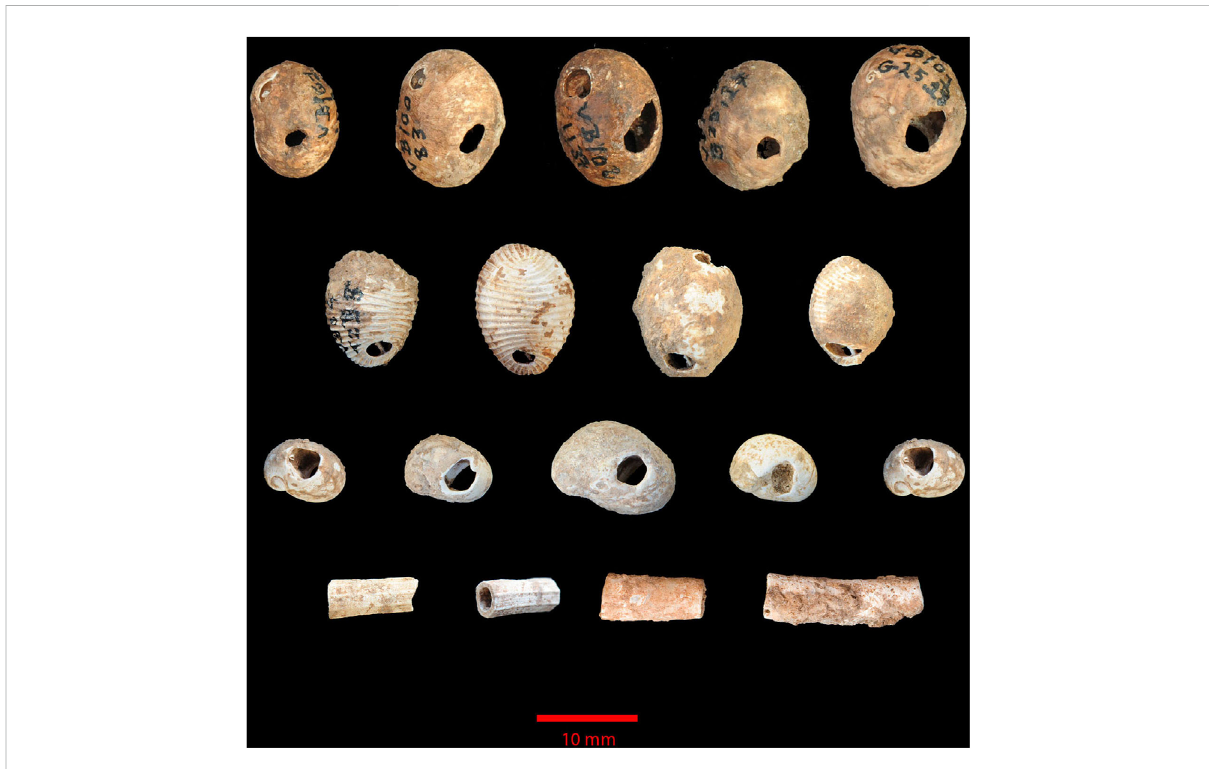
FIGURE 2 Examples of ornamental perforated shells in the Portuguese Upper Paleolithic. Top to bottom: Littorina obtusata from Vale Boi; Trivia sp from Vale Boi; Theodoxus fl uviatilis from Vale Boi; Antalis from Vale